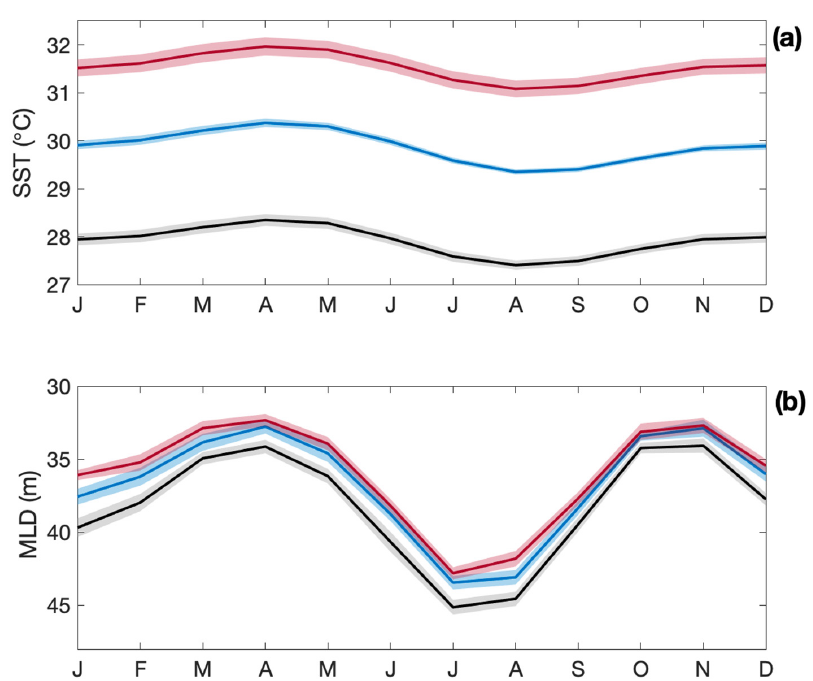
Figure 5. Climatology ( ± 2 SE) of ( a ) SST and ( b ) MLD for a contemporary (black) and end-of-century climate modeled under two emission scenarios: SSP2-4.5 (blue) and SSP5-8.5 (red) scenarios for the tropical ocean (20 °N–20 °S).